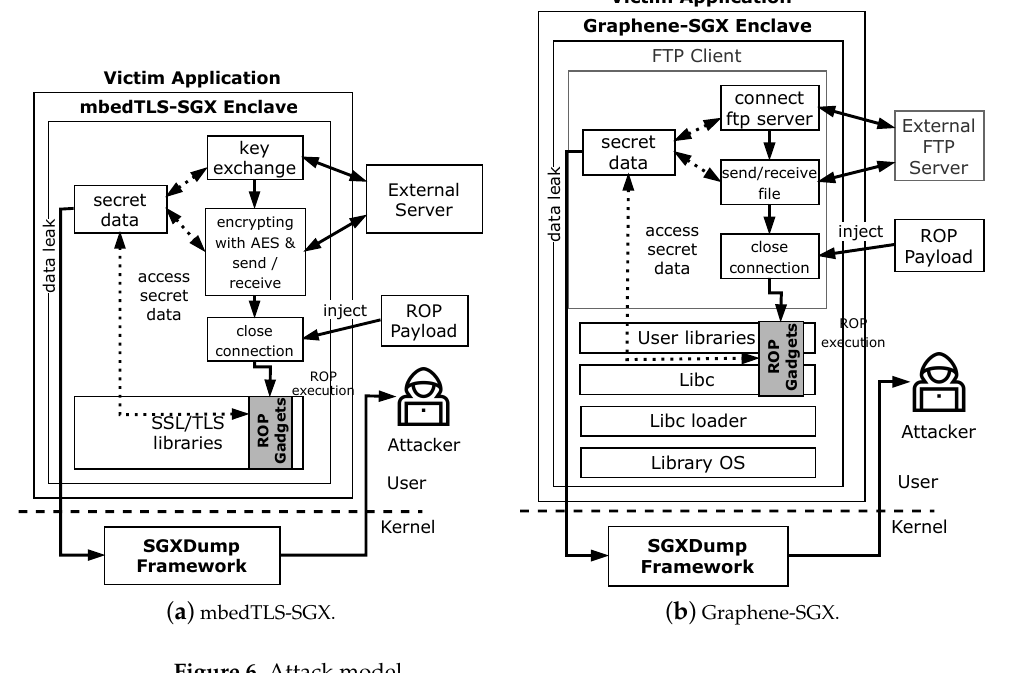
Figure 6. Attack